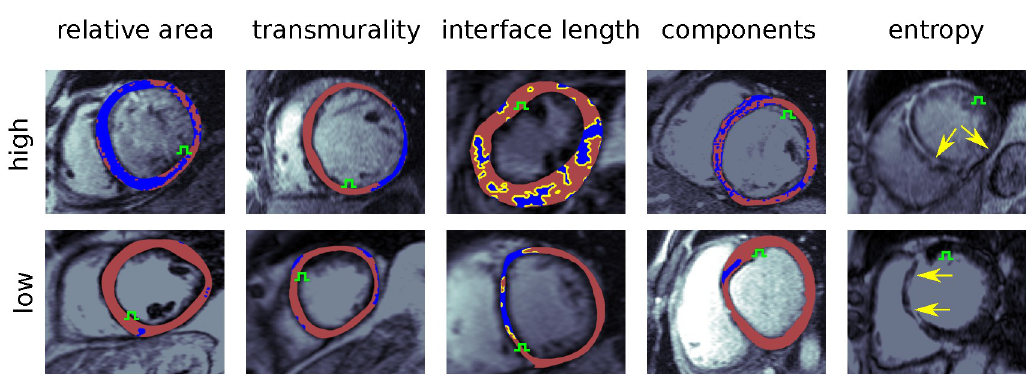
Fig 6. Example LGE-CMR images demonstrating high and low feature values. Areas in blue are LGE, whereas the yellow border in the interface length column shows the location of the myocardial-LGE interface. The green symbols show the stimulus sites. For the entropy images the segmentation masks are not shown to allow for visual comparison of the LGE texture.